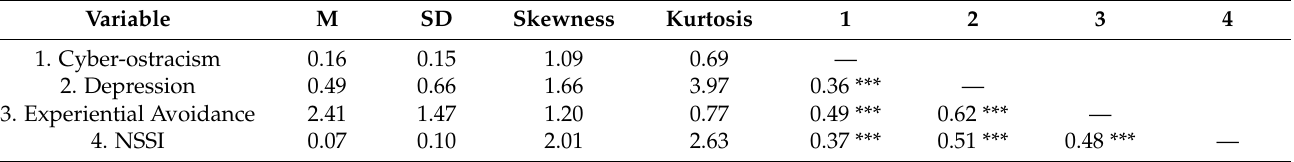
Table 1. Descriptive statistics and correlations for the main